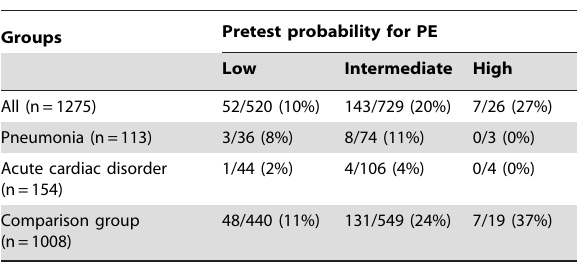
Table 2. Cases of concomitant presence of PE and another disease that could mimic PE.